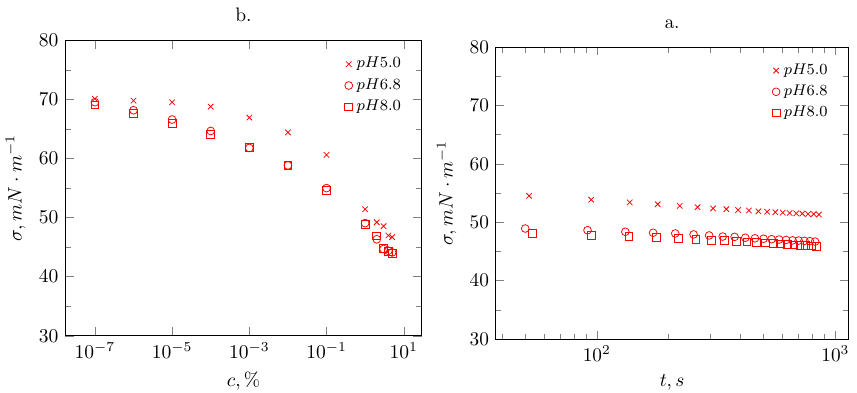
Figure 2. Surface properties of Vicia faba L. protein isolate solutions for various pH; ( a ) surface tension in function of concentration, ( b ) surface tension in function of time for 1% protein